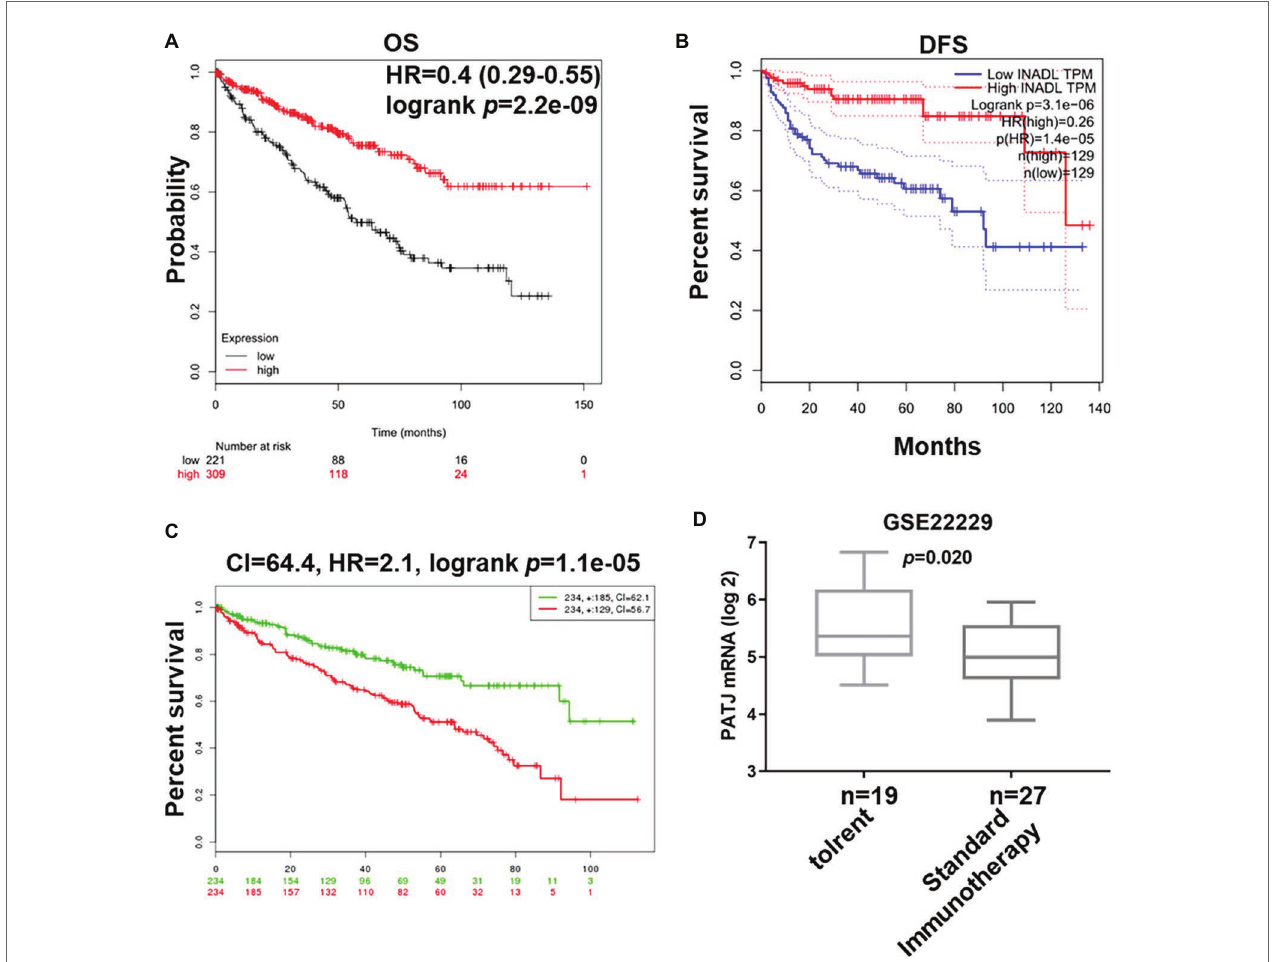
FIGURE 3 | Association of PATJ mRNA levels with ccRCC prognosis. (A) Kaplan-Meier curves of 530 ccRCC patients stratified by PATJ mRNA level analyzed by using Kaplan-Meier Plotter (http://kmplot.com/analysis/). (B) Kaplan-Meier curves of 258 ccRCC patients stratified by PATJ mRNA level analyzed by using the GEPIA (http://gepia.cancer-pku.cn/). (C) Kaplan-Meier curves of 468 ccRCC patients stratified by PATJ mRNA level analyzed by using the SurvExpress (http:// bioinformatica.mty.itesm.mx:8080/Biomatec/SurvivaX.jsp). (D) PATJ expression data from GSE22229 were stratified by patients with kidney